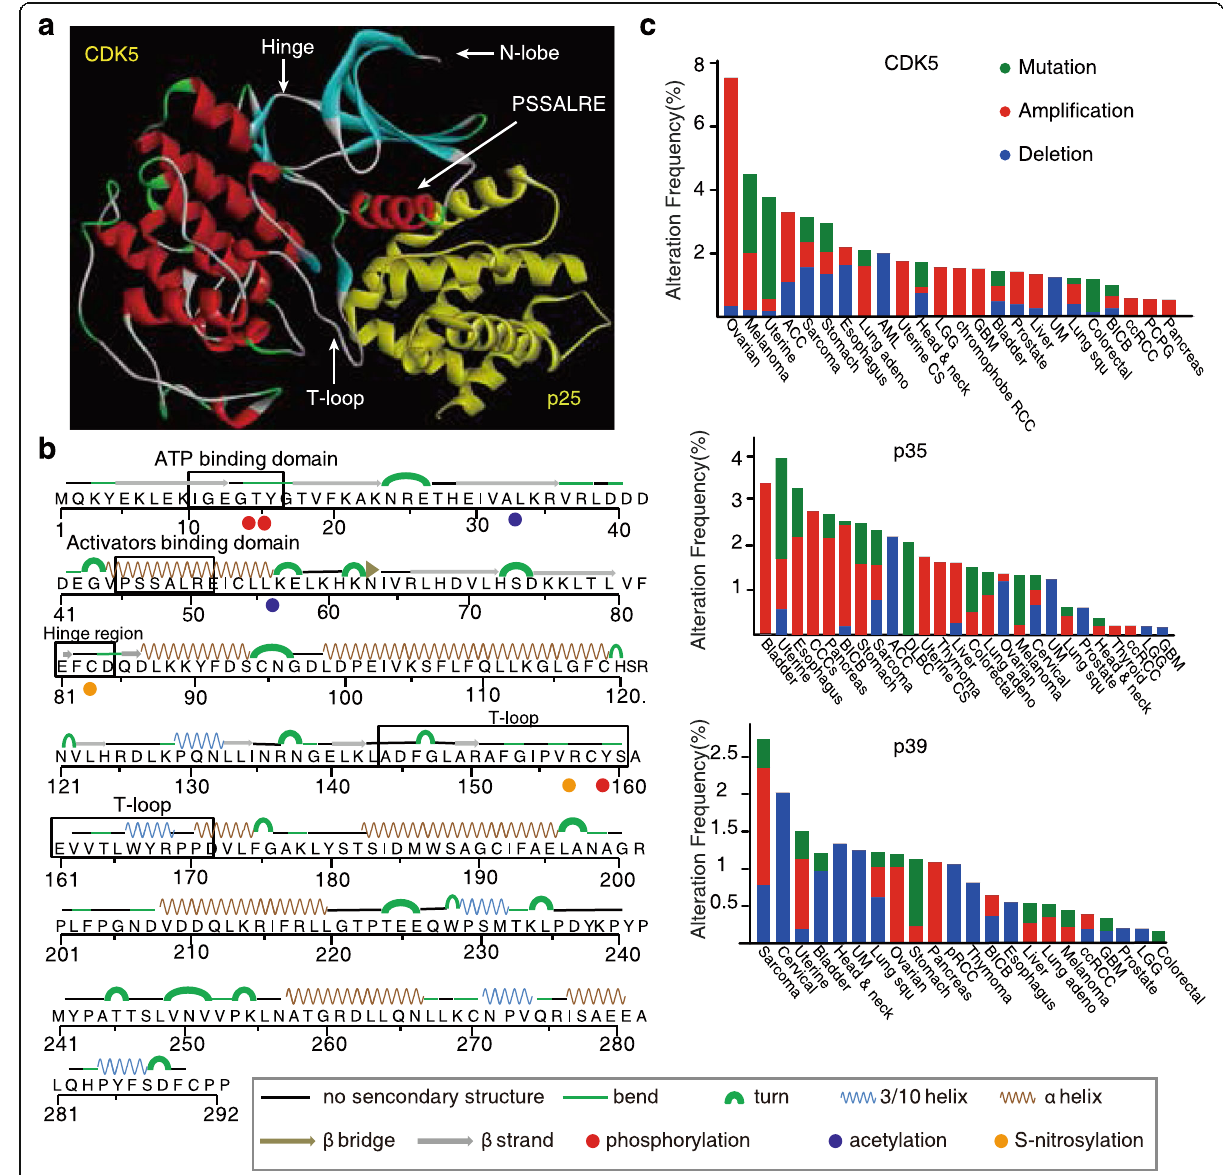
Fig. 1 The structure and amino acid sequence of CDK5 and its expression in cancers. a The interaction between CDK5 and p25 (yellow). CDK5 structurally contains an ATP binding domain, activators binding domain, hinge region, PSSALRE helix and T-loop. The N lobe mainly contains 5 β - sheets and C lobe includes 4 α -helices. b CDK5 amino acid sequence contains β -bridge, bend, turn, β -strand and a-helix sequence. The PTM sites are labelled with colors: phosphorylation, red; acetylation, blue; S-nitrosylation, yellow. c The genomic alterations including mutation, amplification and deletion of CDK5 as well as p35 and p39 were analyzed in clinical samples from cBioPortal